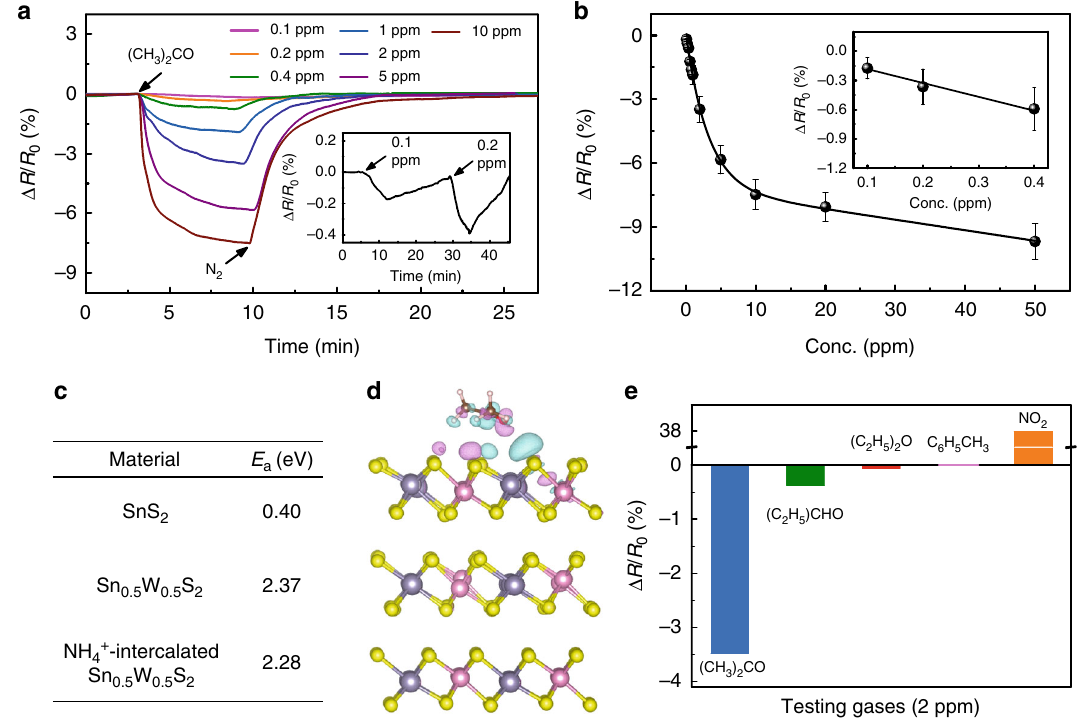
Fig. 7 Gas sensing performance of Sn 0.5 W 0.5 S 2 /SnS 2 heterostructures. a Response – recovery curves of a typical chemiresistive sensor fabricated from Sn 0.5 W 0.5 S 2 /SnS 2 heterostructures in response to acetone gas with increasing concentrations. Inset: zoom-in response of the sensor towards 0.1 and 0.2 ppm acetone. b Normalized change of resistance of Sn 0.5 W 0.5 S 2 /SnS 2 sensors at various acetone concentrations. Inset: zoom-in normalized change